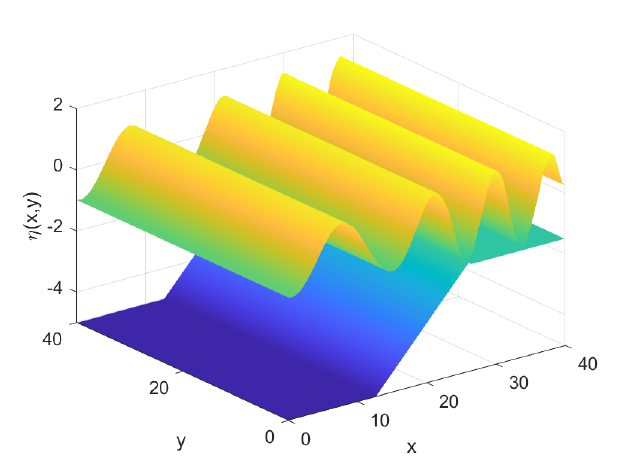
Figure 12. 2-D Numerical Simulation of Wave Shoaling using Artificial